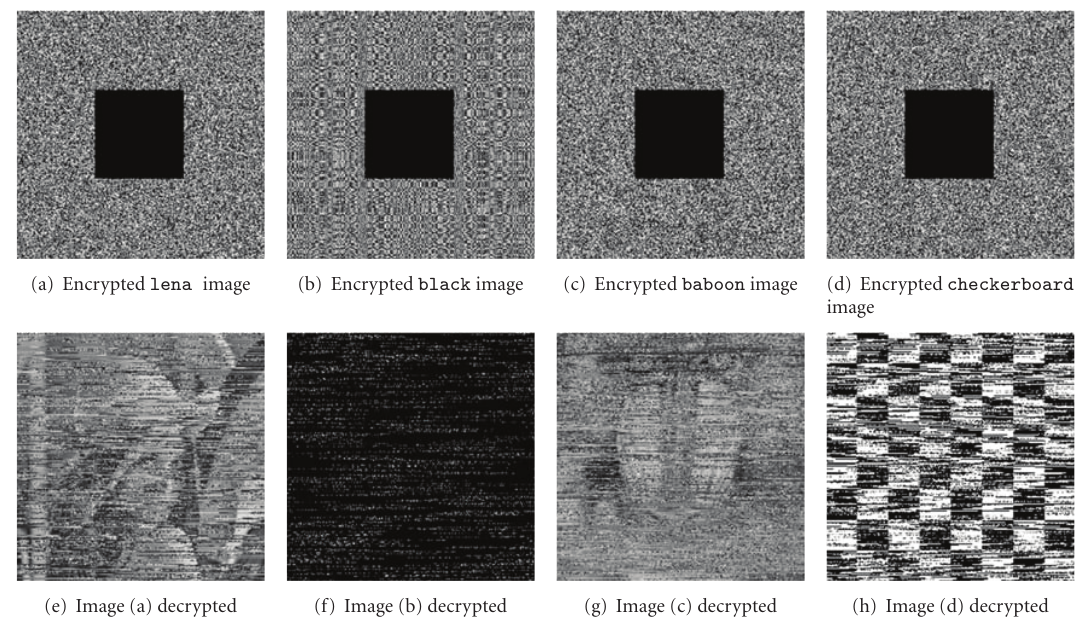
Figure 8: Encrypted images under cropping attack in center (cropping over 1/8 of the entire image area).